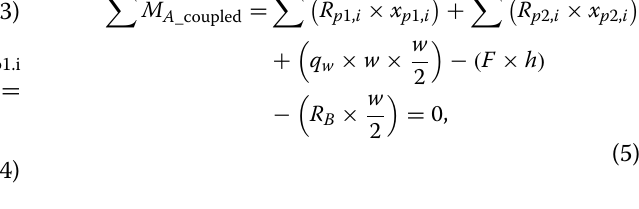
where M A_single moment at the rotation point (A point where δ p2.i displacement of i th connector on panel 2 = = in Fig. 3a) (N mm), R p1,i (mm). tensile resistance of i th con- = nector on panel 1 (kN), x p1,i distance of i th connec- = Coupled‑panel kinematic model tor on panel 1 from rotation point (mm), R p2,i tensile = resistance of i th connector on panel 2 (kN), x p2,i dis- In the coupled-panel kinematic model, there are two = rotation points, A point and B point (Fig. 3b). The lat- tance of i th connector on panel 2 from rotation point (mm), q w vertical load per unit length (kN/m), w eral load capacity of the coupled-panel kinematic model = = width of shear wall (mm), F is calculated by the moment equilibrium at the bottom lateral resistance of shear = right corner of the wall (A point) as shown in Eq. 5. The wall (kN), h height of shear wall (mm). = distance between the connector and the rotation point × w 2 + + R p 1, i × x p 1, i R p 2, i × x p 2, i (cid:28) q w ( x w1,i and x w2,i ) is the distance from the rotation point of 2 (cid:27) (cid:29) (cid:29) (cid:31)(cid:30) F single = (cid:31)(cid:30) each panel (A point or Bpoint ) to each connector. Thus, tensile resistance of a connector on panel 1 can be calcu- lated by Eq. 3 like single model, but the tensile resistance where F single lateral resistance of shear wall by single = of a connector on panel 2 should be calculated by Eq. 6. wall kinematic model (kN).